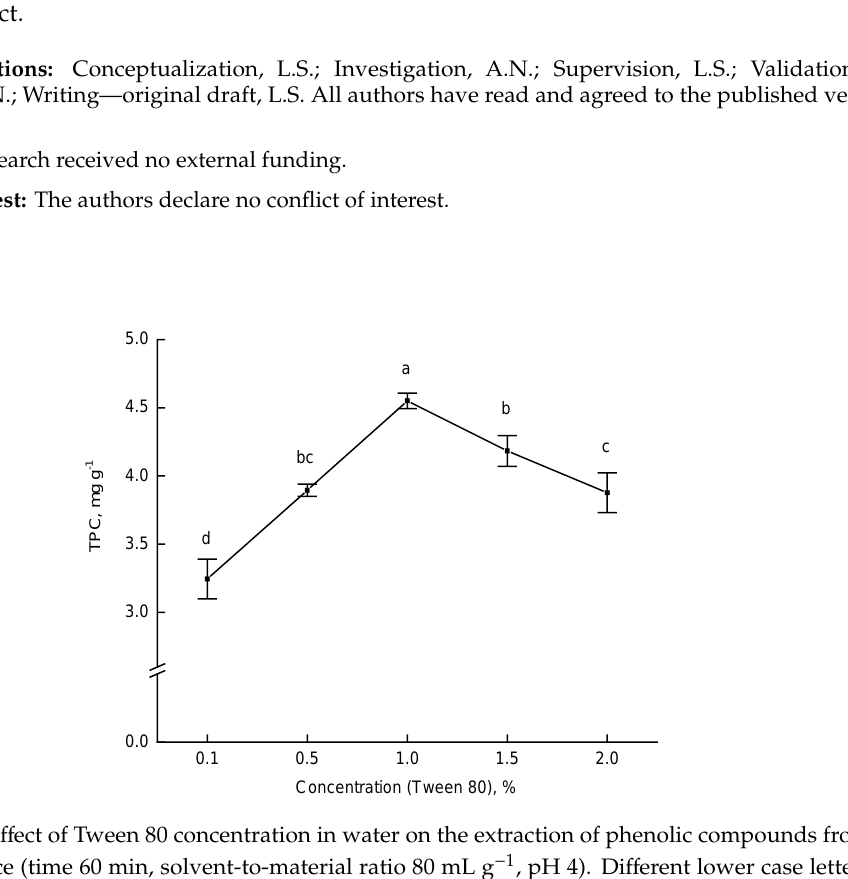
Figure A2. Effect of pH on the extraction of phenolic compounds from apple pomace (C(Tween 80) 1%, time 60 min, solvent-to-material ratio 80 mL g −1 ). Different lower case letters indicate significant differences among treatments ( p ≤ 0.05) based on post hoc Tukey’s test.